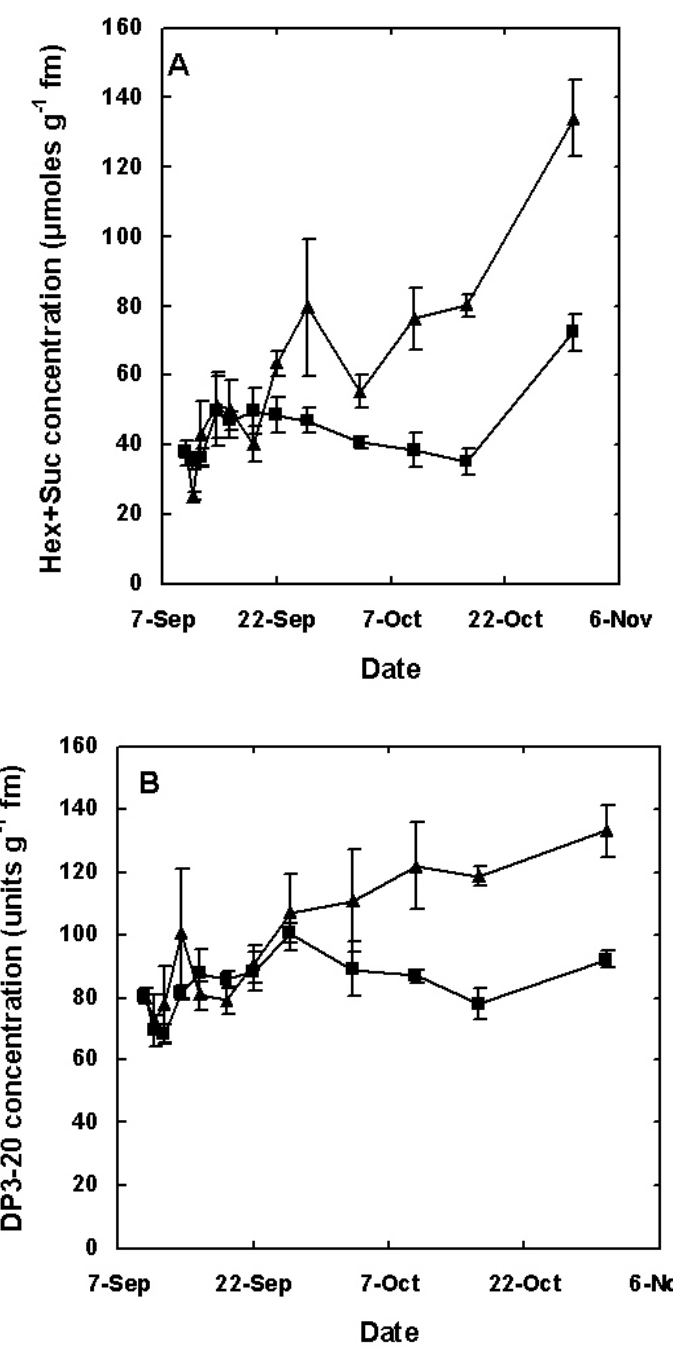
FIGURE 2 . Changes of the Hex + Suc (A), DP3-20 fructan (B) and fructan with DP > 20 (C) concentrations in the roots of intact ( ■ ) and defoliated ( ▲ ) field-grown chicory